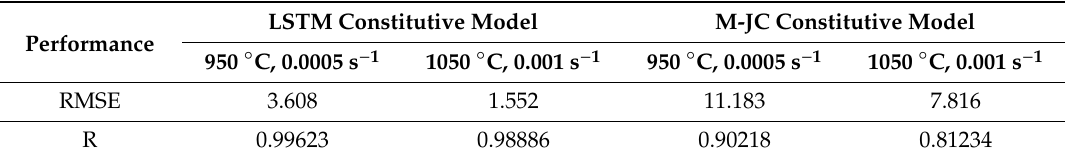
Table 3. Comparison of prediction performance between LSTM and M-JC in plasticity